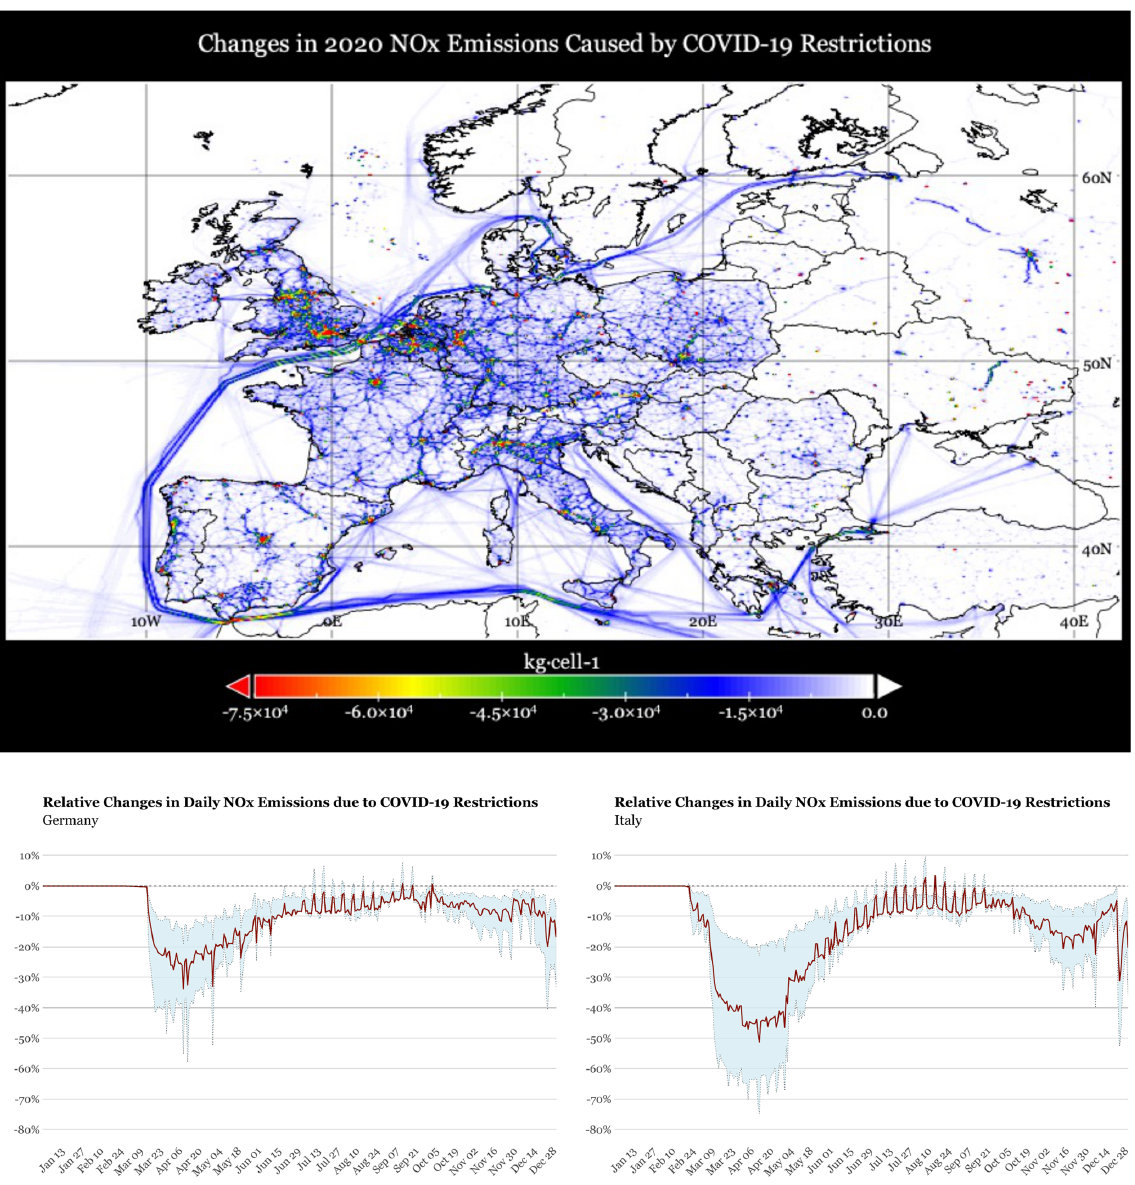
Figure 12. Map of the absolute cumulative NO x emission decline [kg per cell] in 2020 as compared to the business-as-usual scenario. Gridded emission changes are reported at a resolution of 0 . 1 ◦ × 0 . 05 ◦ . Administrative boundaries are derived from the Micro World Data Bank (MWDB2, 2011) (top). Average (dark red) and 5th and 95th percentiles (light blue shading) of the relative changes [%] in gridded NO x emissions in Germany (bottom left) and Italy (bottom right) for the period 1 January to 31 December